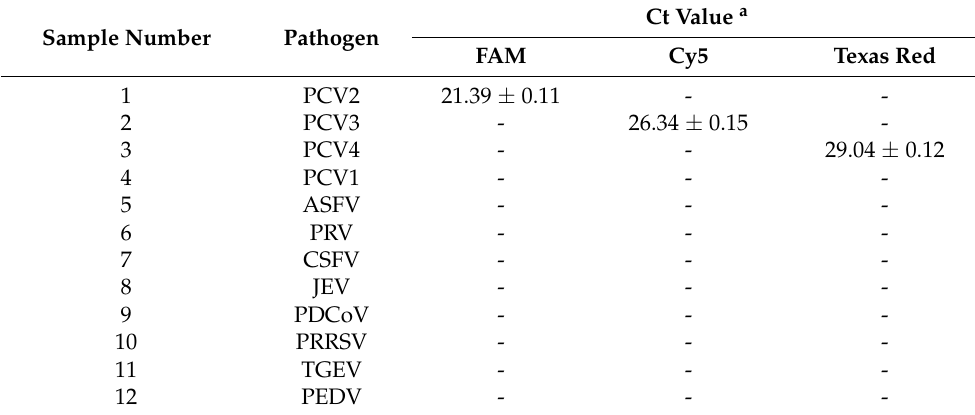
Figure 2. Amplified curves of specificity analysis of multiplex TaqMan qPCR. Table 3. Ct values of specificity analysis of multiplex TaqMan qPCR. Table 3. Ct values of specificity analysis of multiplex TaqMan qPCR.